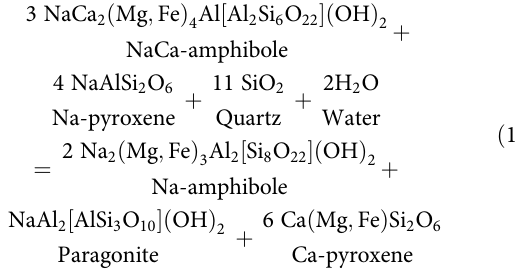
Fig. 2a. The amorphous material forms a direct physical link between reactants and product surfaces where precipitation occurs directly by repolymerization from the amorphous